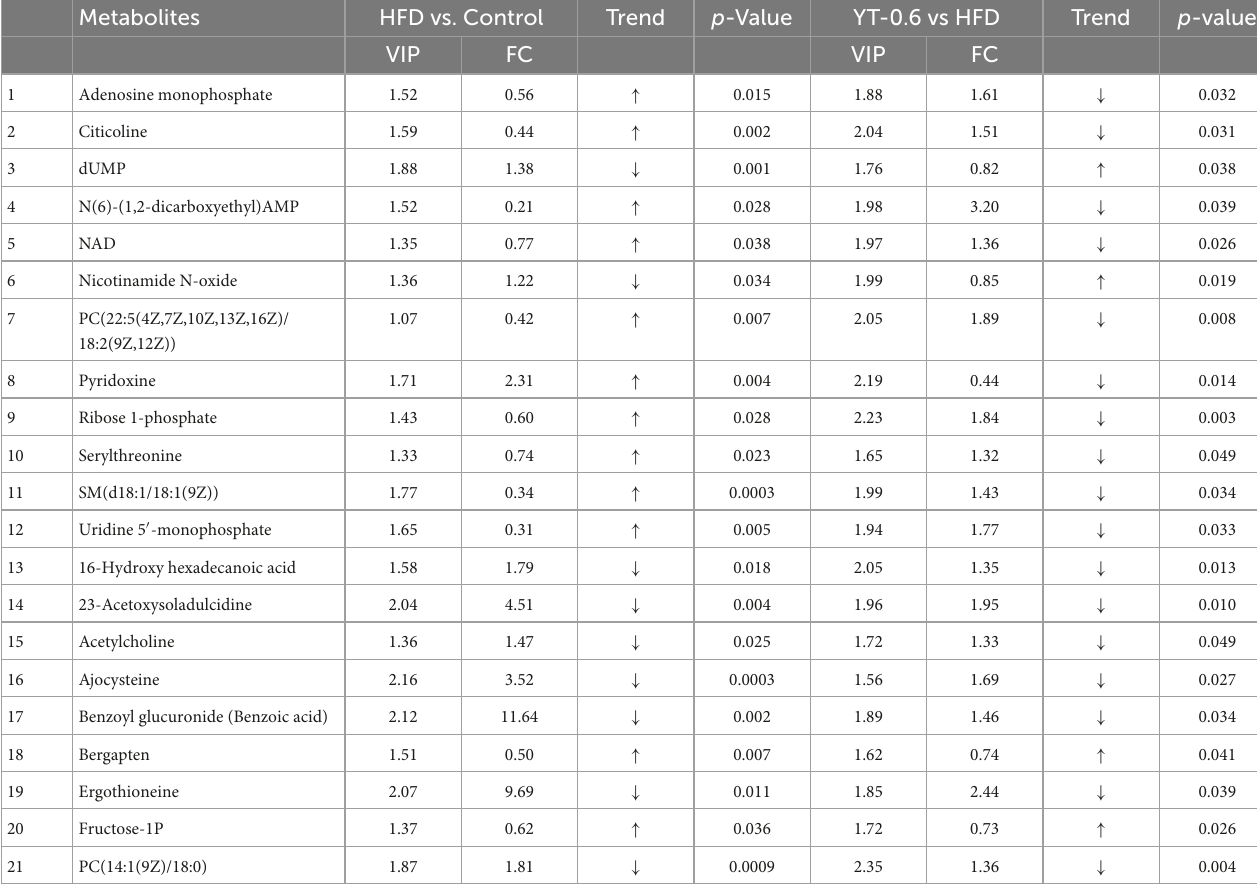
TABLE 3 Differential metabolites were determined by cross-comparison between different groups (control and HFD groups, and HFD and YT-0.6 g/kg groups) using mouse liver samples. Metabolites HFD vs. Control Trend p -Value YT-0.6 vs HFD